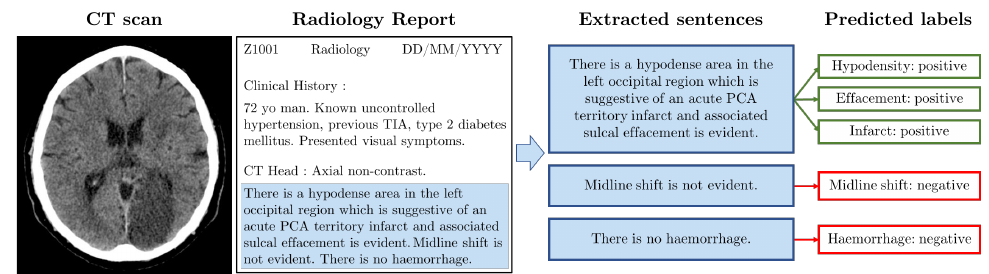
Figure 2. Example radiology report. The image ( left ) shows a slice from an example CT scan (Case courtesy of David Cuete, Radiopaedia.org, rID: 30225); there is a visible darker patch indicating an infarct. The synthetic radiology report ( middle left ) has a similar format to the NHS GGC data. We manually filter relevant sentences ( middle right ). The boxes ( right ) indicate which labels are annotated for each of the three